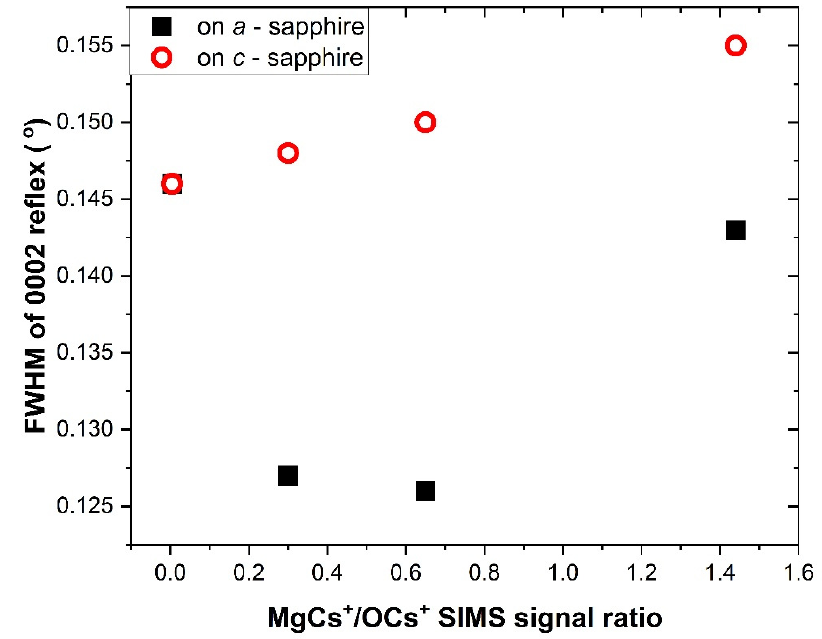
Figure 3. Full width a half maximum of 0002 peaks in the samples grown on a -sapphire (black squares) and on c -sapphire (red circles).